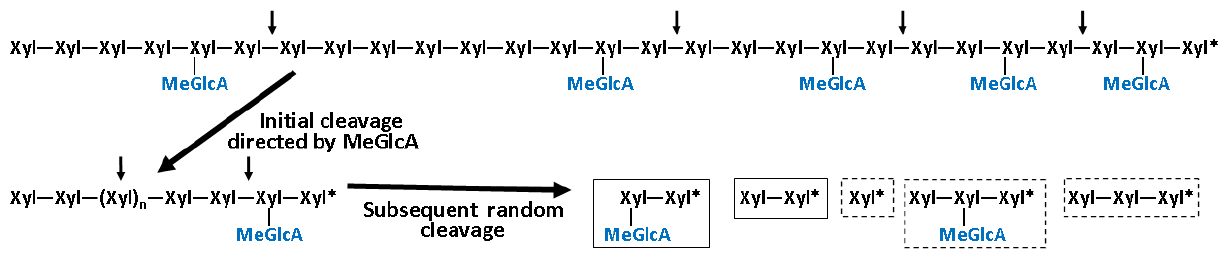
Figure 5. Schematic presentation of the mode of Tl Xyn30A action on glucuronoxylan. Initially, the polysaccharide is converted to a mixture of aldouronic acids of a general structure MeGlcA 2 Xyl n . Later, the unsubstituted regions are also attacked by the enzyme, yielding aldotriouronic acid MeGlcA 2 Xyl 2 and Xyl 2 as major products (in solid boxes) that are accompanied with small amounts of aldotetraouronic acid MeGlcA 2 Xyl 3 , Xyl, and Xyl 3 (dashed boxes) as limit hydrolysis products.